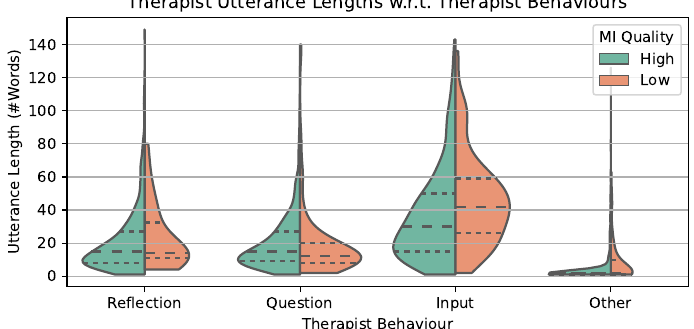
Figure 8. Utterance lengths (number of words) of different therapist behaviours in high- and low- quality MI.